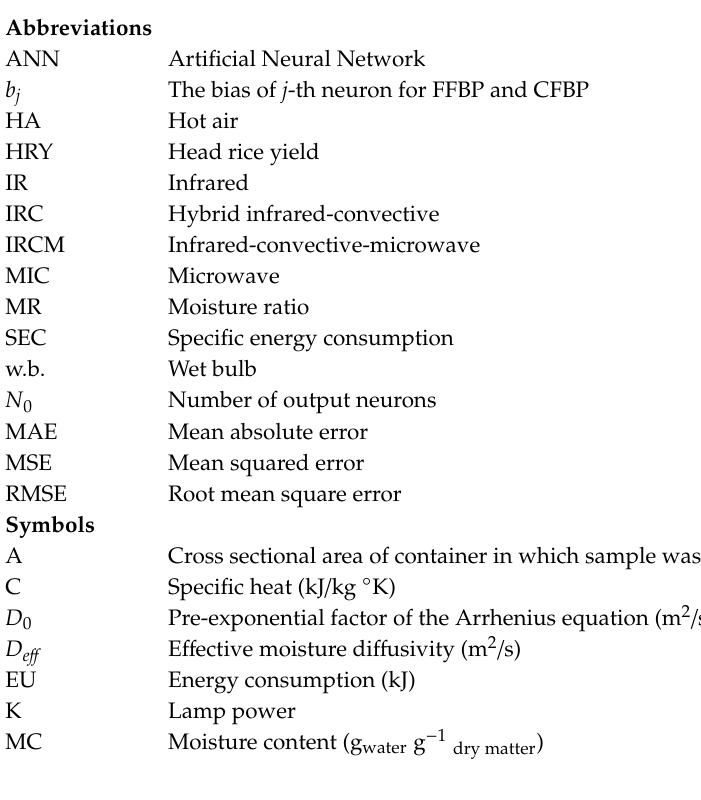
Figure S1: Schematic view of the experimental infrared convective-microwave drying: (1) fan and electric motor, (2) electrical heater, (3) duct and air tunnel, (4) infrared-convective chamber, (5) infrared lamp, (6) inverter and thermostat, (7) microwave chamber, (8) precision balance, (9) computer, (10) thermometer, (11) hygrometer, and (12) chassis, Figure S2: E ff ect of drying di ff erent methods on MR during drying of parboiled rice (( a ): IRC drying; ( b ): IRCM drying; ( c ): MIC drying), Table S1: Statistical comparison for prediction of